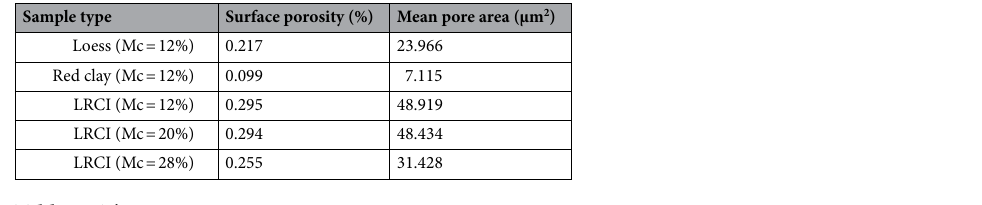
Table 3. The micro-porosity